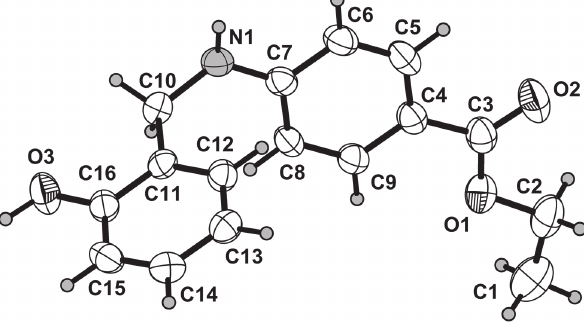
Table 1: Data collection and handling.